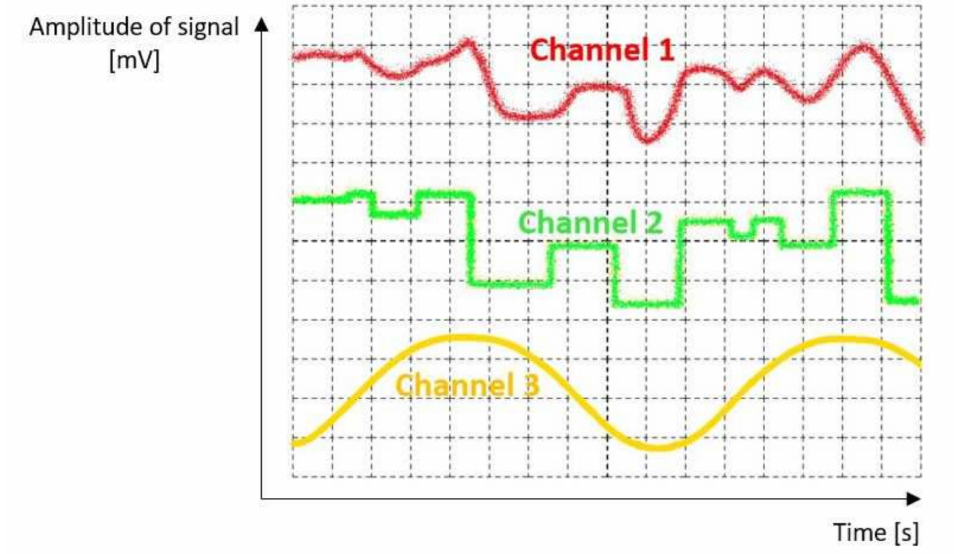
Figure 4. Sample of graphic courses of Doppler signal (after “digitization”), clock and switching signal. Channel 1 (noise + useful audio signal + Doppler shift) represents an audio signal processed from the receiver, which is affected by Doppler shift. Channel 2 (useful audio signal + Doppler shift after modulation and noise filtration). Channel 3 (clear Doppler shift signal)—signal after low-pass filtration.